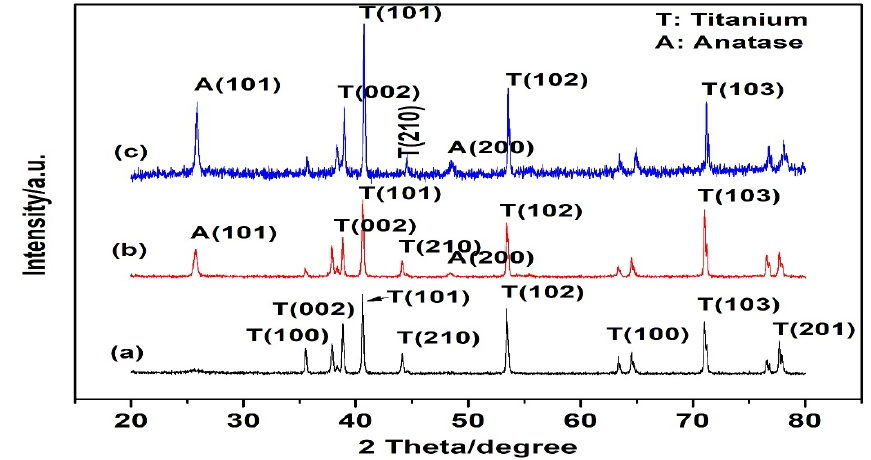
Figure 1. XRD pattern of ( a ) as-anodized TNTs, ( b ) TNTs calcined at 500 ° C for 2 h and ( c ) R-TNTs.